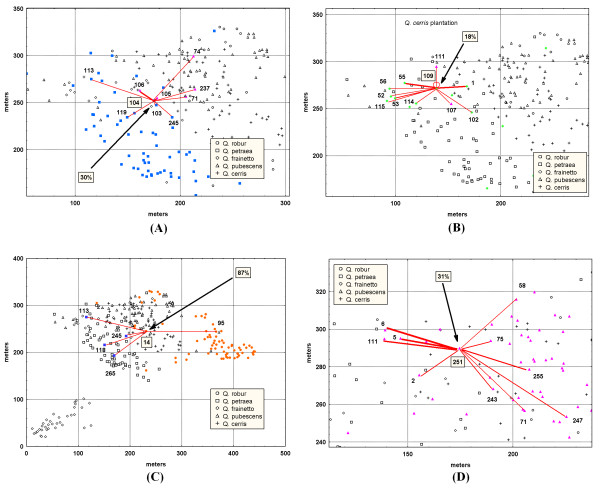
Spatial distribution of four maternal trees belonging to different oak species (A - Q. petraea, B - Q. frainetto, C - Q. robur and D - Q. pubescens, respectively) and their pollen donors within the study plot. Each pollen donor is linked to the corresponding maternal tree through a line. The thickness of each line is proportional to the number of successful matings. The proportion of pollen coming from outside the study plot is also given. Each species is shown by a different shape and colour. Phenotypically intermediate individuals are indicated by the symbols of the species they mostly resemble.